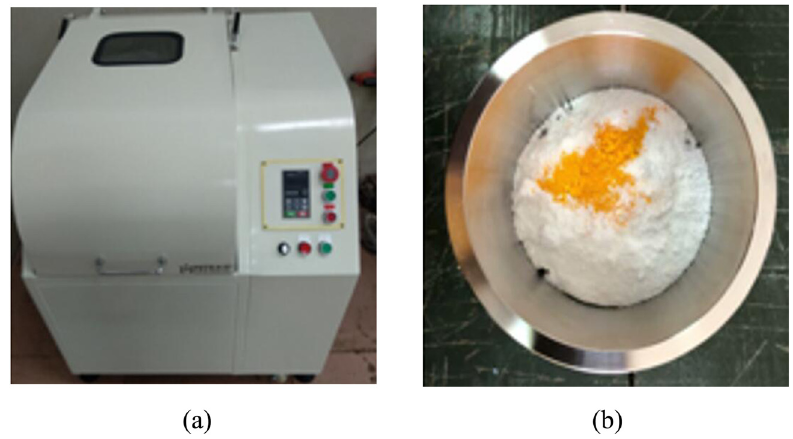
Figure 1: Preparation of nanocomposite catalyst. ( a ) Ball mill ( b ) preparing